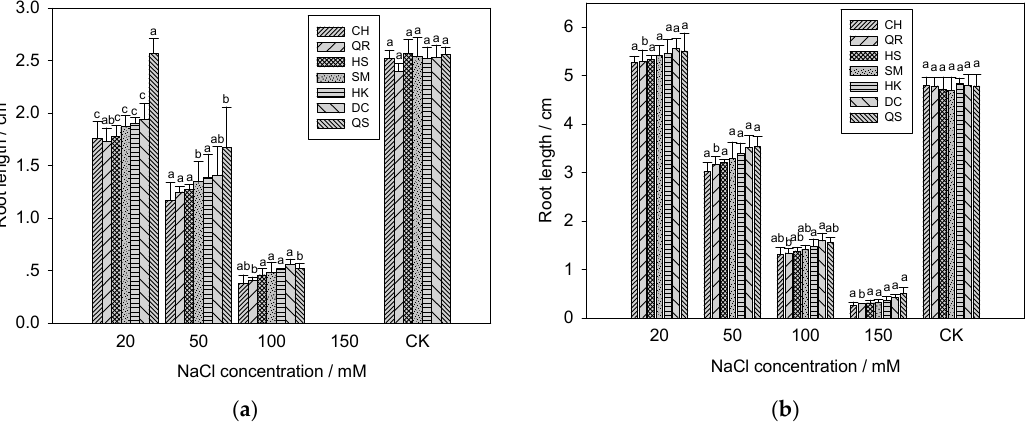
Figure 3. The root length (cm) of E. crus ‐ galli with four NaCl concentrations at different time points. The root length (cm) of E. crus ‐ galli under four NaCl concentrations at 4 days ( a ) and 7 days ( b ) after treatment. Lowercase letters are expressed as least square means ± standard error ( p < 0.05).